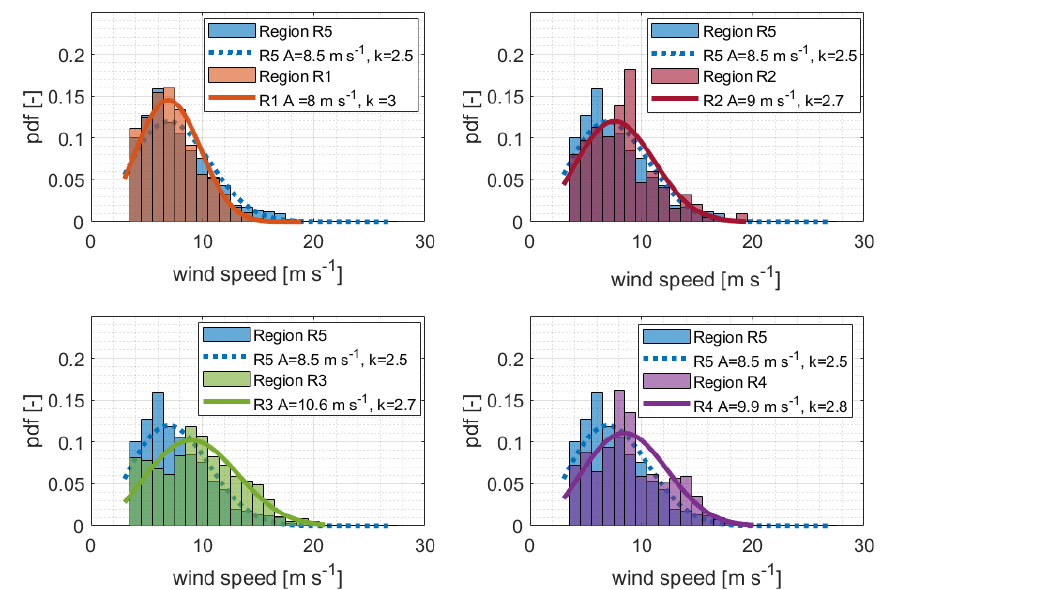
Figure B1. Weibull probability density function (pdf) of wind speed scanning lidar per wind sector area. The sector R5 is used as a